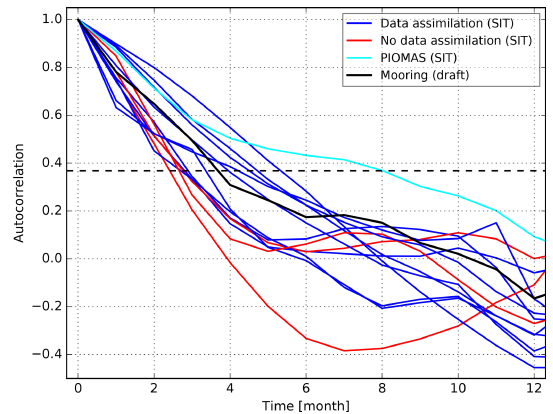
Figure 2. Autocorrelation curves for the draft time series sampled in situ by upward-looking sonars deployed in the BGEP oceano- graphic mooring (black line). This mooring was placed at 150 ◦ W, 75 ◦ N (see location in Fig. 3c), and the data span from August 2003 to August 2013. The blue and red lines display the autocorrelation estimated from the SIT anomalies time series for the ORA-IP re- analyses, at the nearest grid point to the mooring and same time span, for the reanalyses built with and without sea ice data assimi- lation, respectively. The cyan line indicates the autocorrelation es- timated for the PIOMAS reanalysis. The time in which the curves cross the black dashed line is defined as their respective e -folding